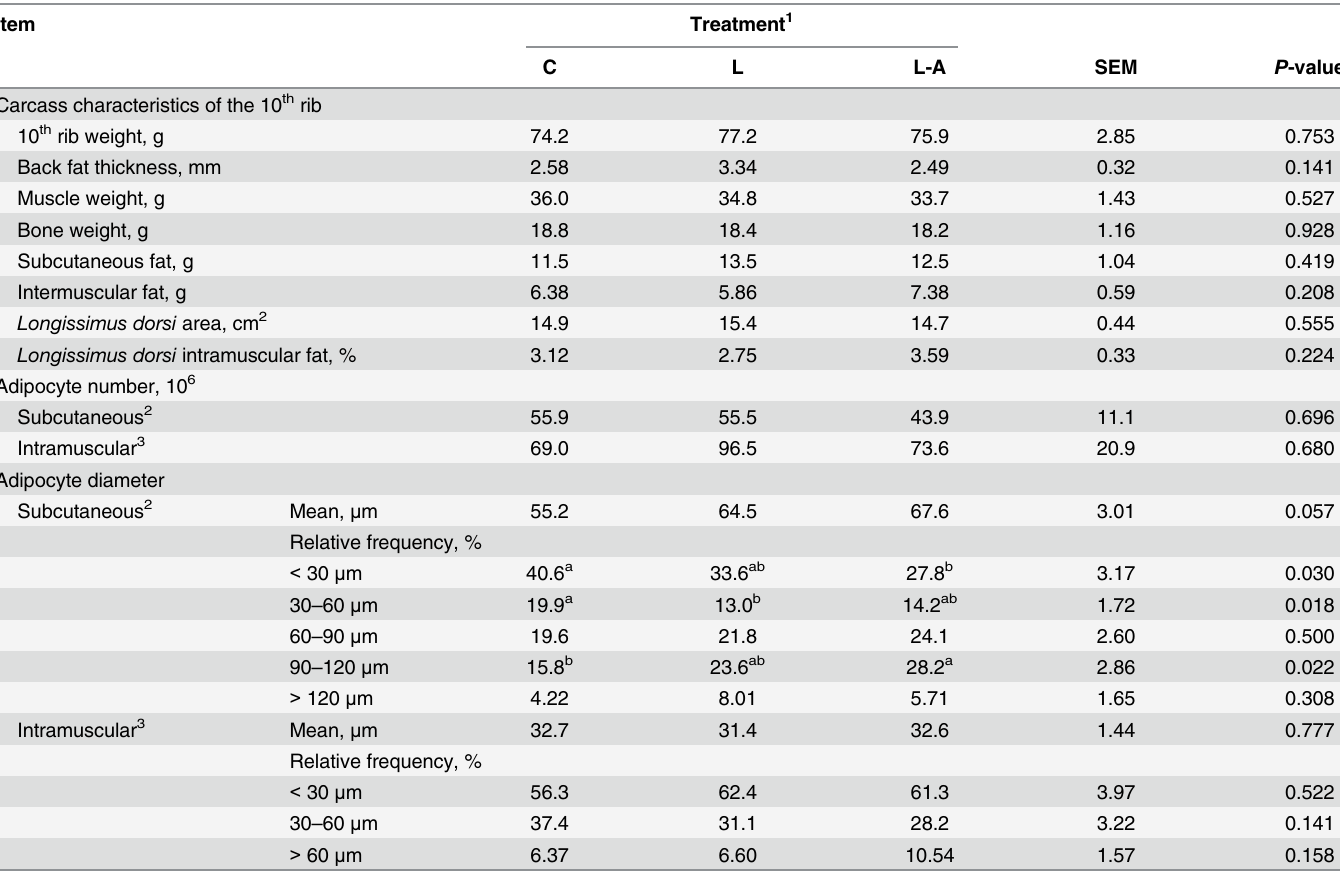
Table 3. Effects of addition of linseed or linseed and marine algae to the diet on carcass traits of the 10 th rib, number and diameter of adipocytes in subcutaneous and intramuscular adipose tissue of Navarra breed lambs.